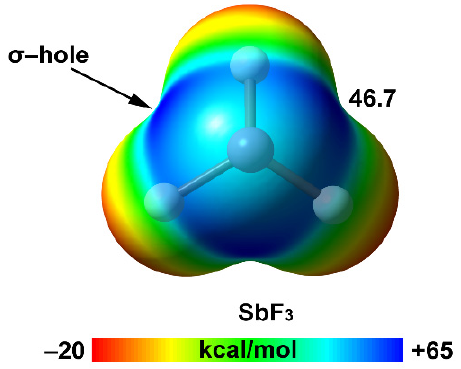
Figure 2. MEP surface of SbF 3 at the MP2/def2-TZVP level of theory at the 0.001 a.u. isovalue (energy in kcal/mol).